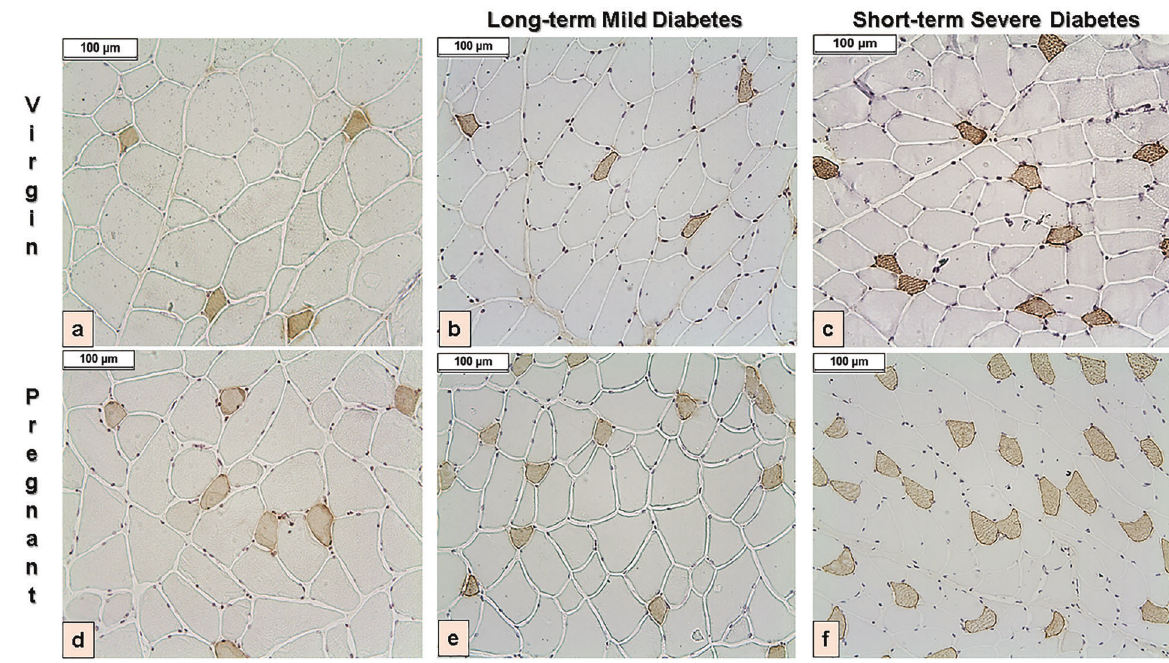
Figure 3. Immunohistochemistry images of slow fi bers in a transverse section of rat rectus abdominis. Virgin ( a ), long-term mild diabetic ( b ), short-term severe diabetic ( c ), Pregnant ( d ), long-term mild diabetic pregnant ( e ), and short-term severe diabetic pregnant (f). Magni fi cation 20 (cid:1)